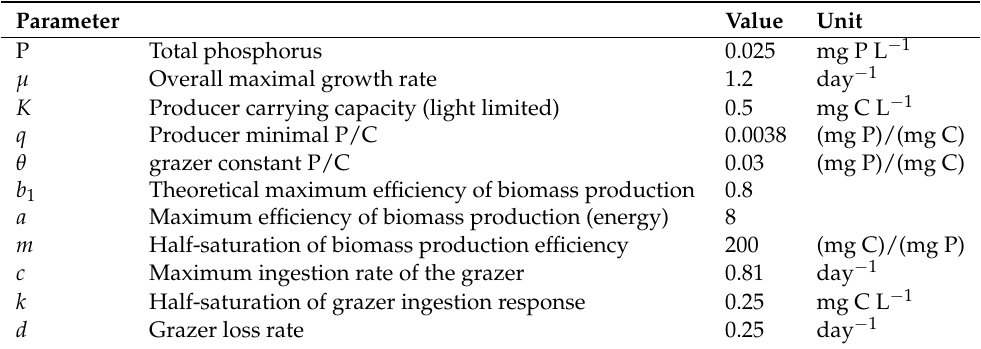
Table 1. Baseline parameter values taken from [10,12]. a and m were chosen so that α ( · ) gives values in the proximity of b 1 (note that α ( · ) varies with the model